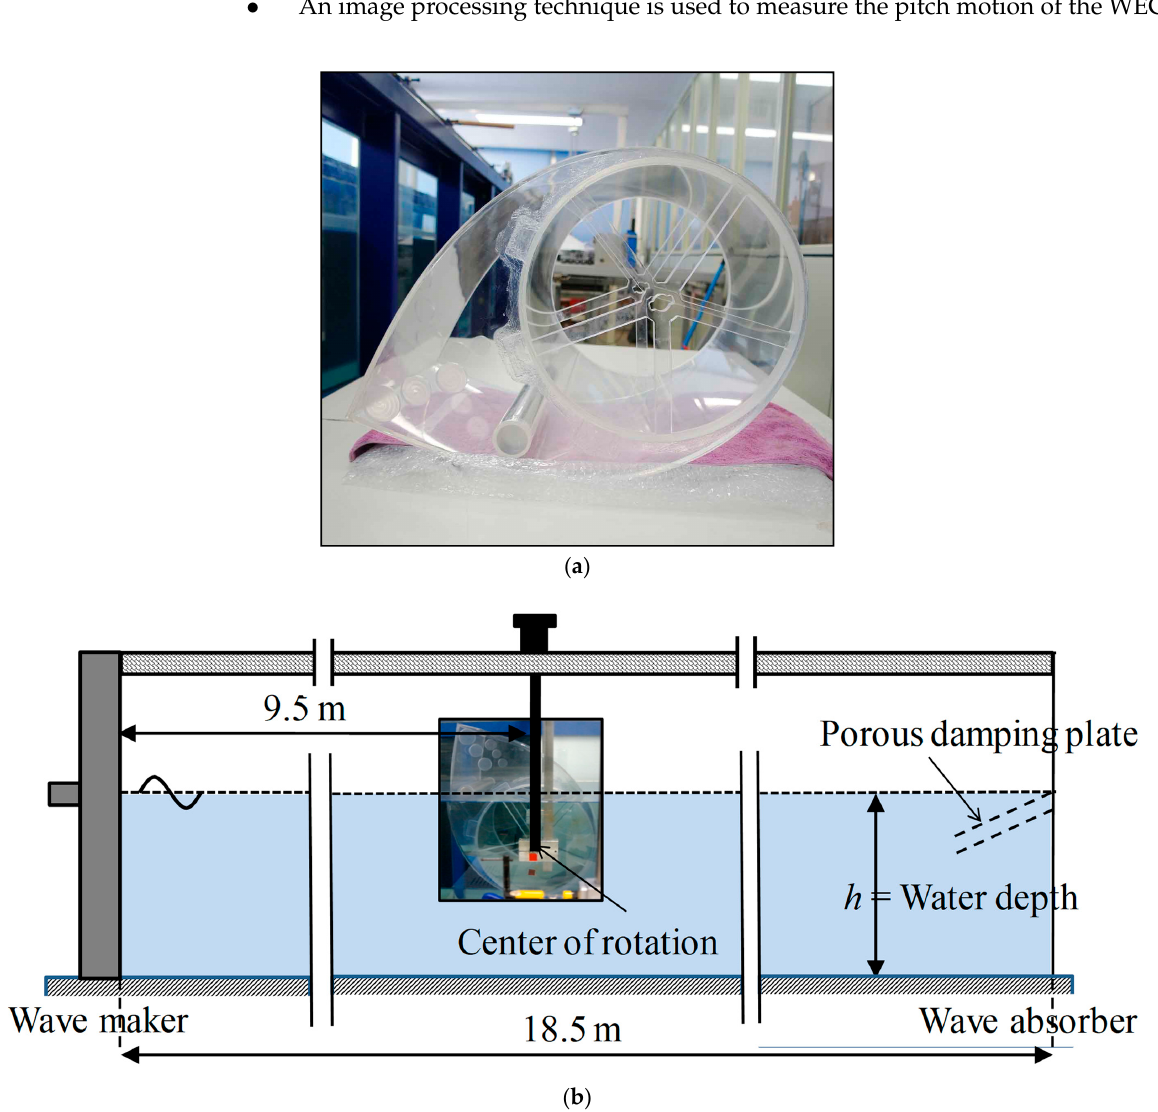
Figure 3. ( a ). Scale-down WEC rotor model and ( b ) schematic view of the experimental setup equipped with the WEC rotor in the wave flume.